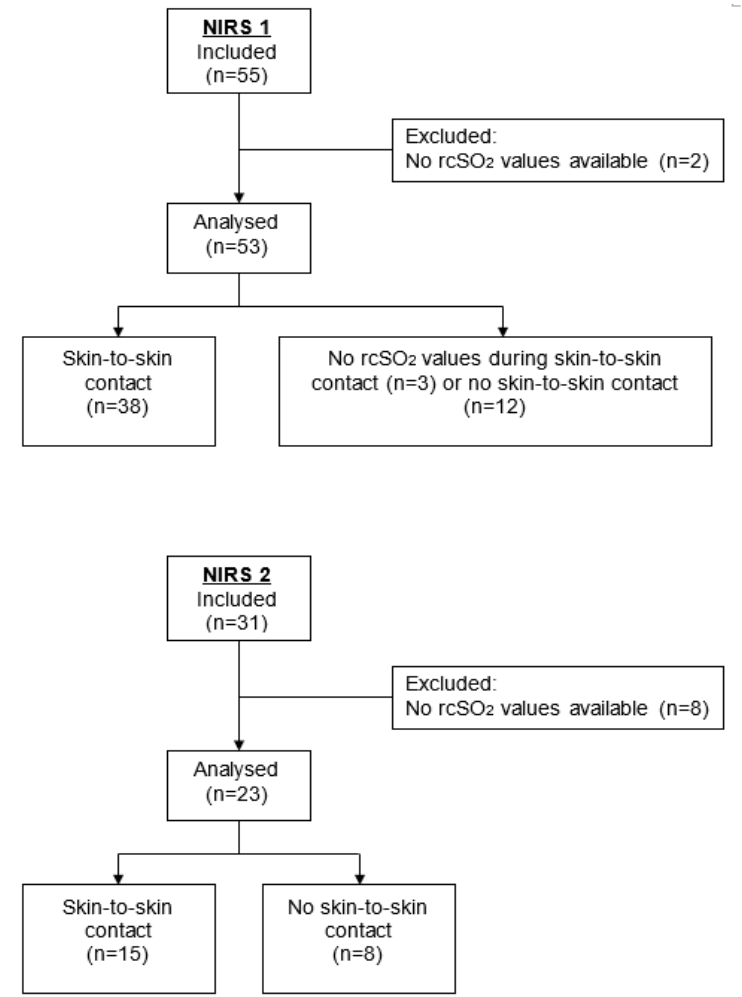
Figure 1. Flow diagram of the observational study cohorts .